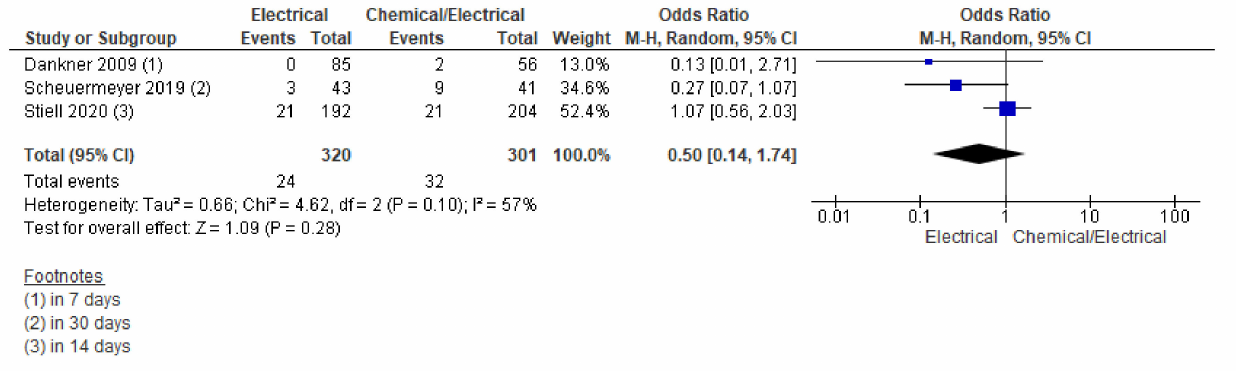
Figure 4. Forest plot showing ED visit rate across electrical and chemical followed by electrical cardioversion group using random effect model